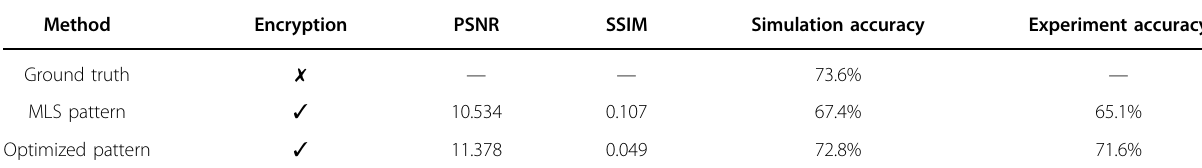
Table 1 Privacy protection degree and face recognition accuracy in our method and MLS pattern